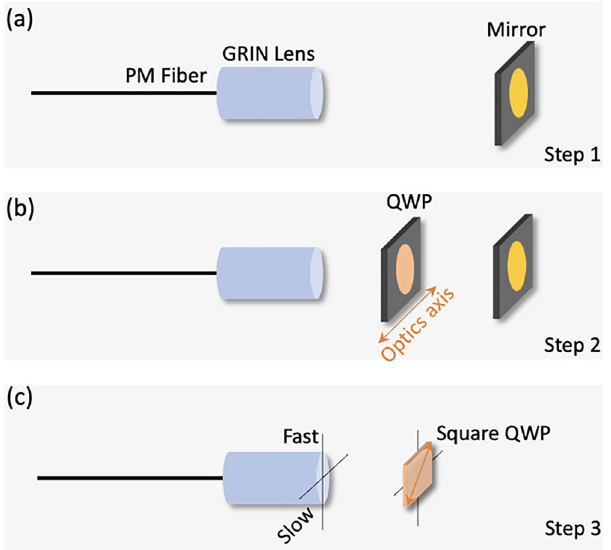
Figure 8. Detailed procedure of fabricating imaging probe. ( a ) Step 1. ( b ) Step 2. ( c ) Step 3. The figure is generated by using PowerPoint (Version 16.58, https:// www. micro soft. com/ en- us/ micro soft- 365/ power